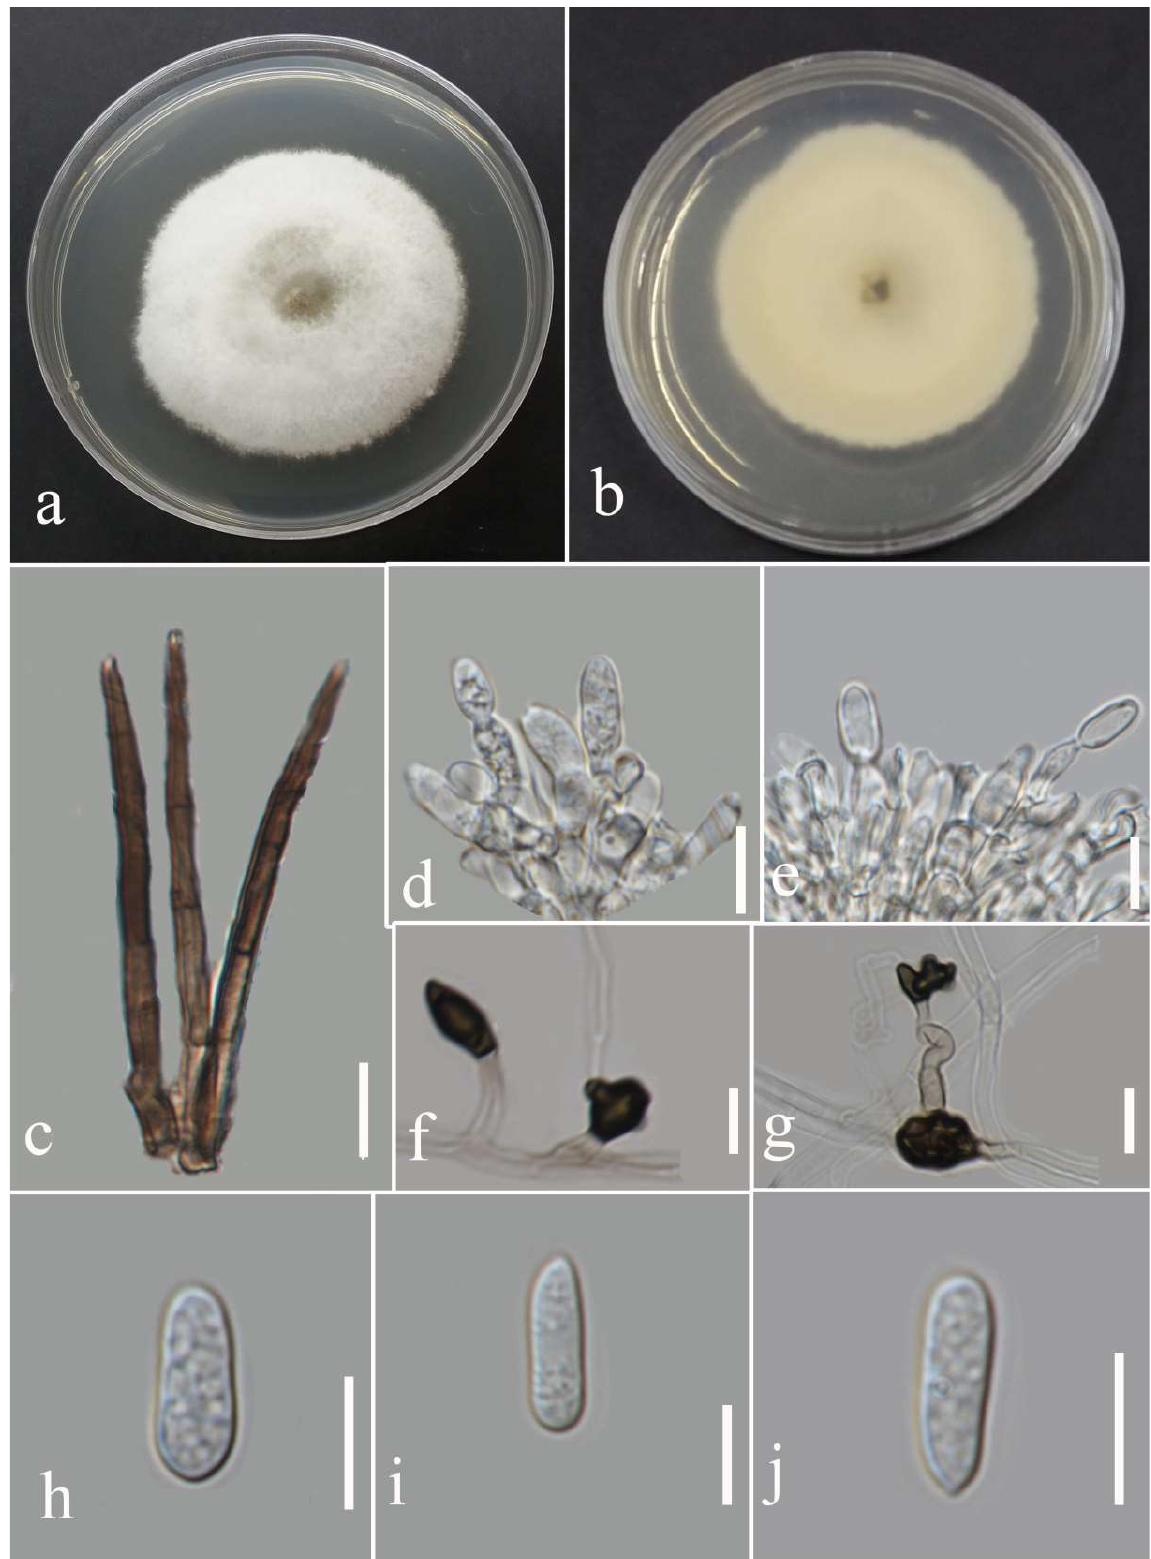
Figure 23. Morphology of Colletotrichum pandanicola (MFLUCC 22 - 0137) obtained from Nephrolepis cordifolia : ( a , b ) upper and reverse views of the colony after seven days of growth on PDA at 28 °C; ( c ) setae; ( d , e ) conidiogenous cells; ( f , g ) appresoria; ( h – j ) conidia . Scales bars = 10 µm .